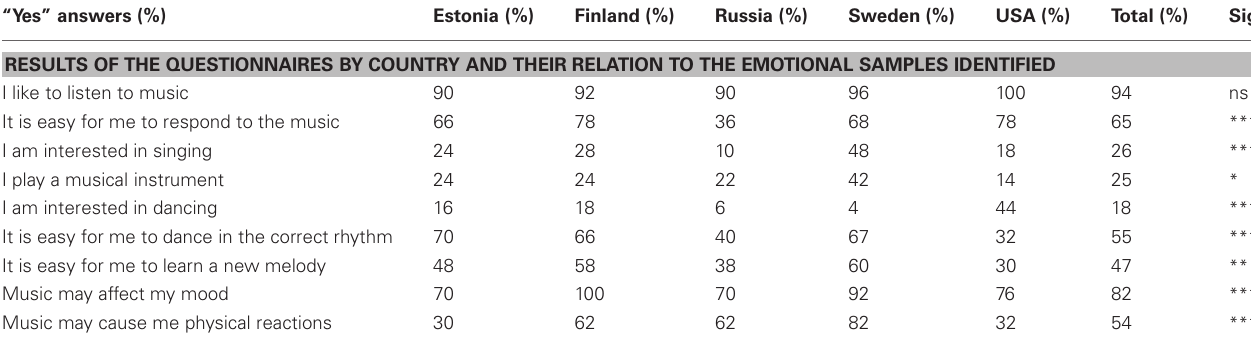
Table 3 | The results of the 250 questionnaires from the five countries studied and their relation to the identified emotions. “Yes” answers (%)